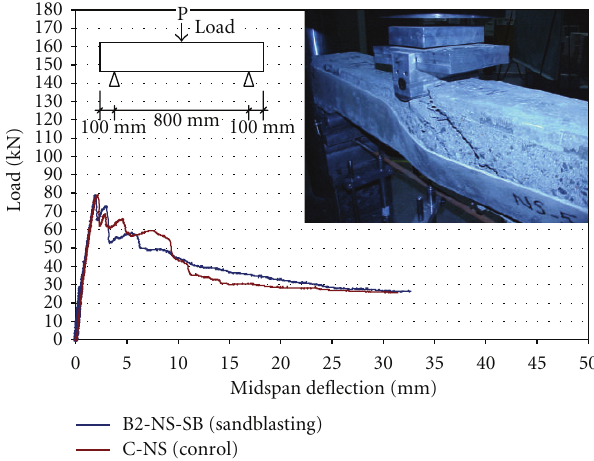
Figure 12: Load versus midspan deflection of RC beam B2-NS-SB.